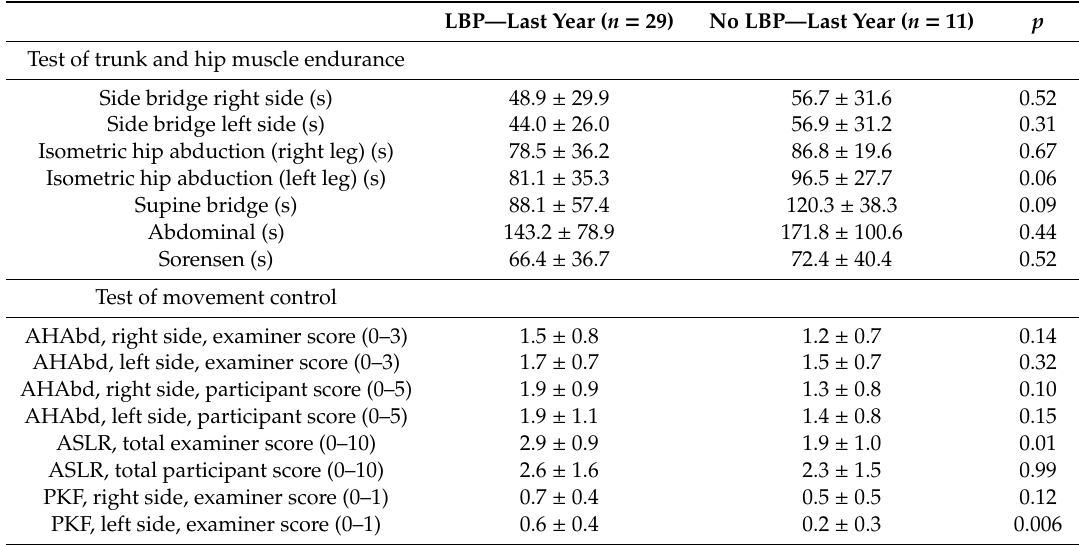
Table 3. Di ff erences in physical outcome measures for participants with and without history of lower back pain (LBP) in the past